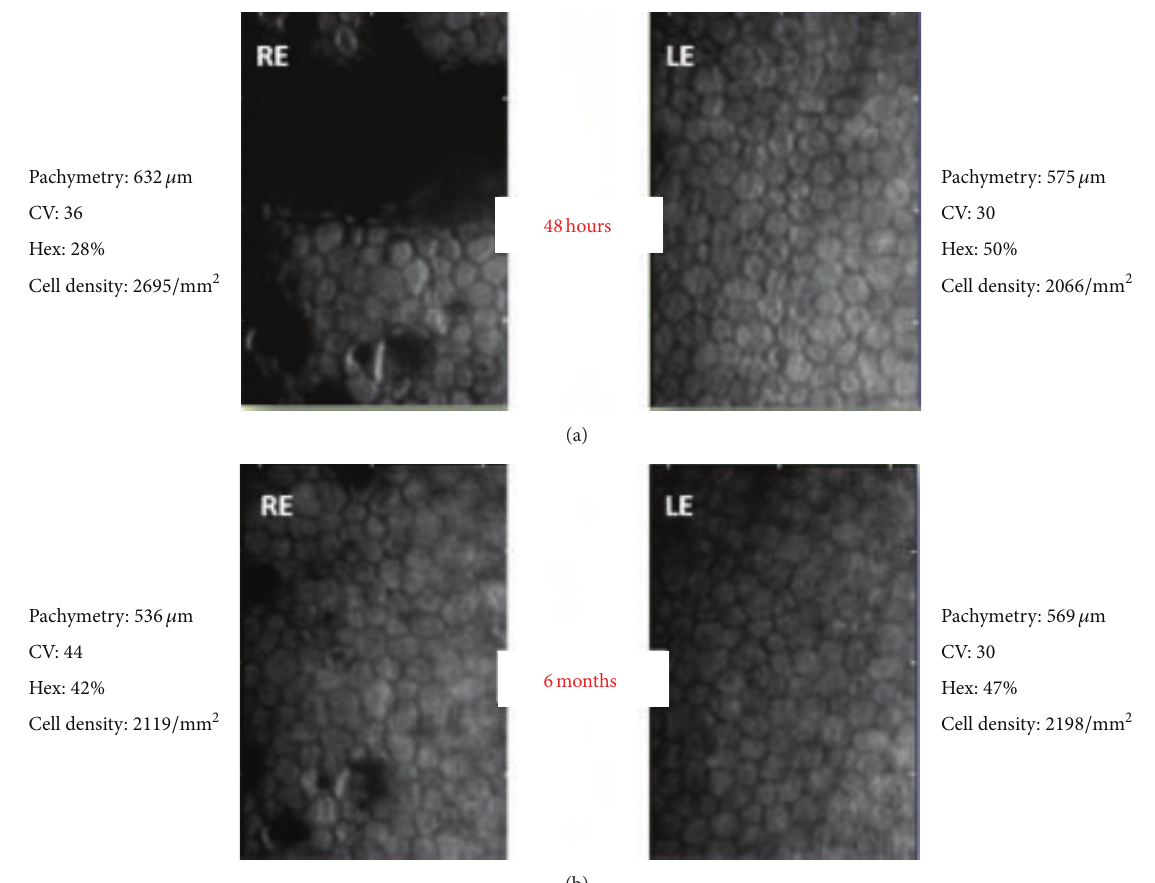
Figure6: Specular microscopy oftheREshowspolymegathism and pleomorphism;CV: coefficient of variation; Hex: percentage ofhexagonal